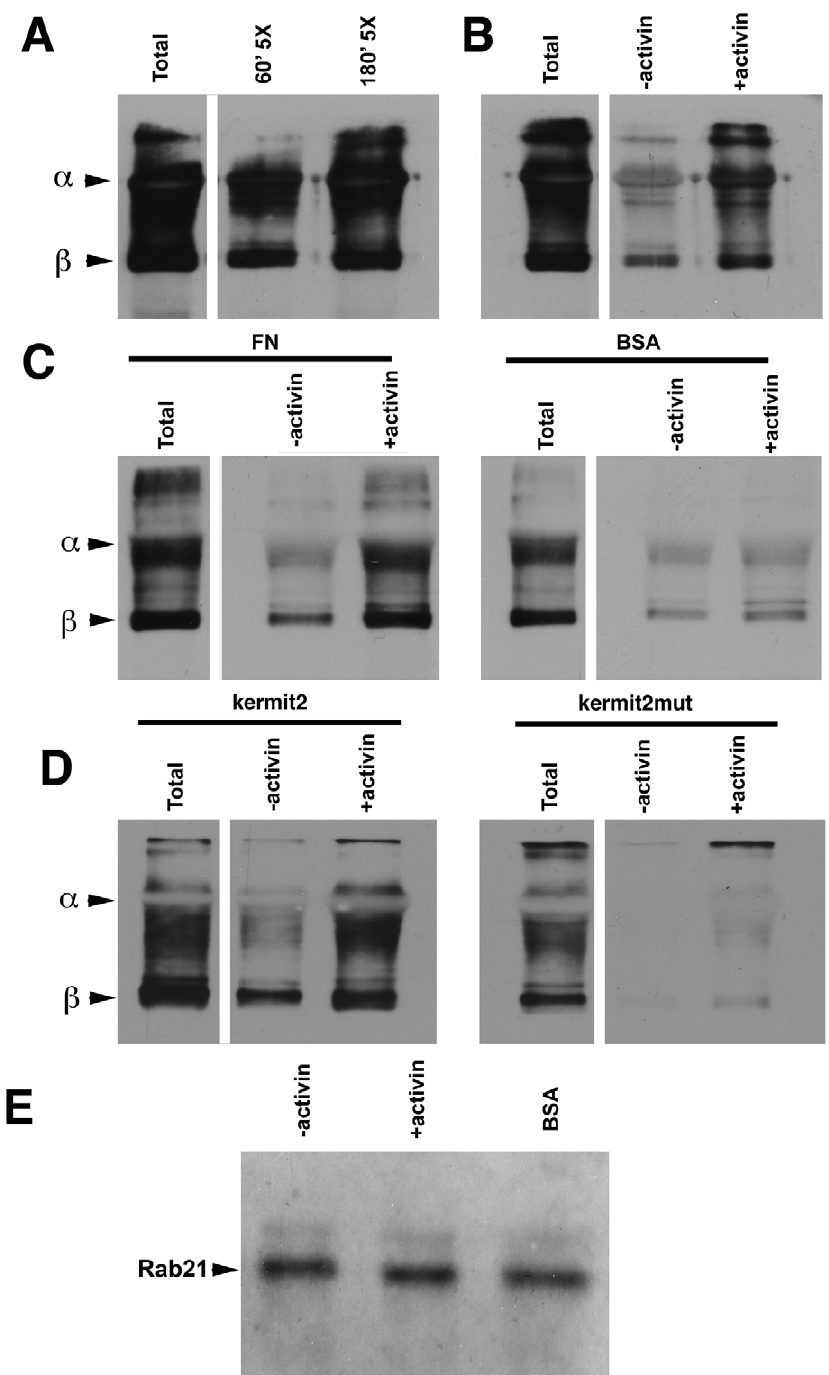
Figure 9. Endocytosis of a 5 b 1 integrin. Cell surface a 5 b 1 integrin was labeled with cleavable biotin and endocytosed integrin was immunoprecipitated and integrin subunits detected with streptavidin HRP on non-reducing western blots. a and b subunits are indicated to the left of the panels. The non-reduced P8D4 IgG used for the immunoprecipitation runs at the same molecular weight as the a subunit partially masking the signal. In all panels the total lane represents five fold more cells than represented in other lanes and the samples were not surface stripped. (A) Time course of a 5 b 1 integrin endocytosis following activin induction. Increasing amounts of a 5 b 1 are found in the cytoplasm at 60 minutes and 180 minutes following activin treatment. (B) a 5 b 1 integrin endocytosis is stimulated by activin induction. Panels A&B come from the same gel and are separated for clarity. (C) Cell adhesion stimulates a 5 b 1 endocytosis. Activin-tretaed cells adherent on FN substrates exhibit an increased rate of endocytosis as compared to cells on a non-adherent (BSA) substrate. (D) Kermit2 regulates a 5 b 1 endocytosis. Activin-treated kermit2 mut expressing cells show reduced levels of a 5 b 1 integrin endocytosis as compared to cells expressing kermit2. (E) Rab 21 coprecipitates with a 5 b 1 integrin independent of mesoderm induction and adhesive substrate. Rab 21 was detected in a 5 b 1 immunoprecipitates with A-14 antibody.